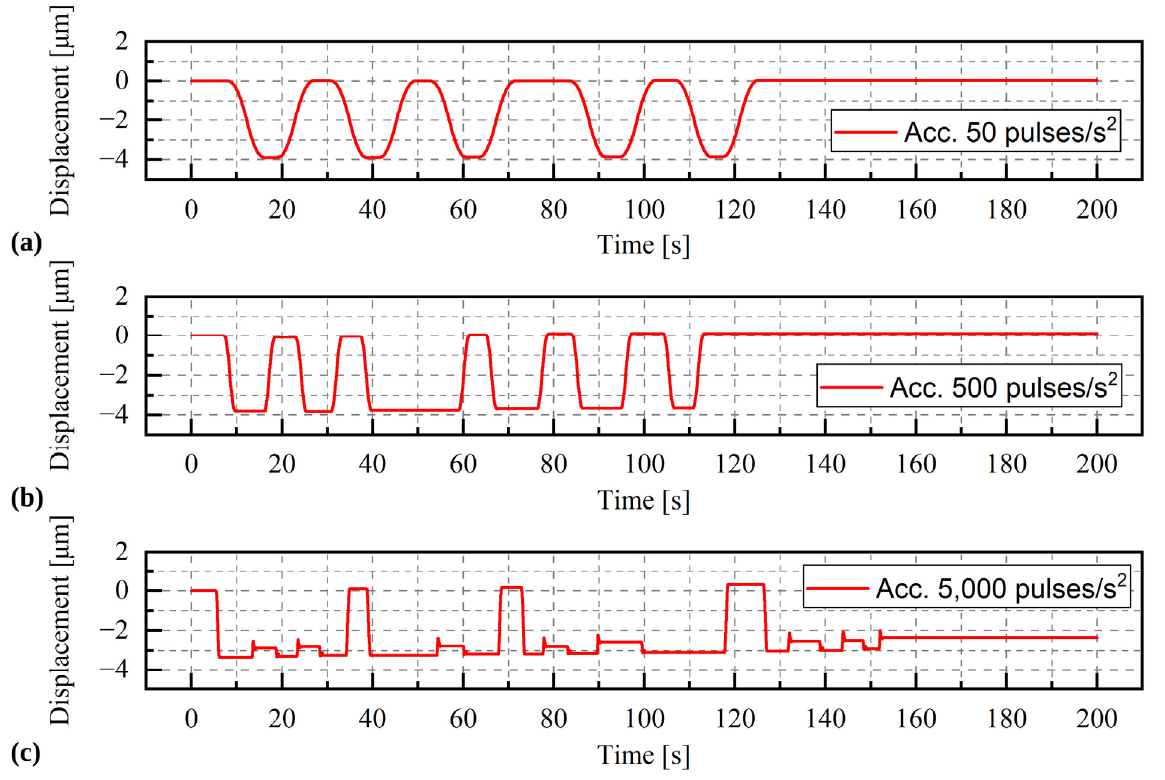
Figure 12. Displacement of the stepper motor with a load of 19.62 kg. During the test the acceleration was change ( a ) acceleration = 50 pulses/s 2 , ( b ) acceleration = 500 pulses/s 2 , ( c ) acceleration = 5000 pulses/s 2 .